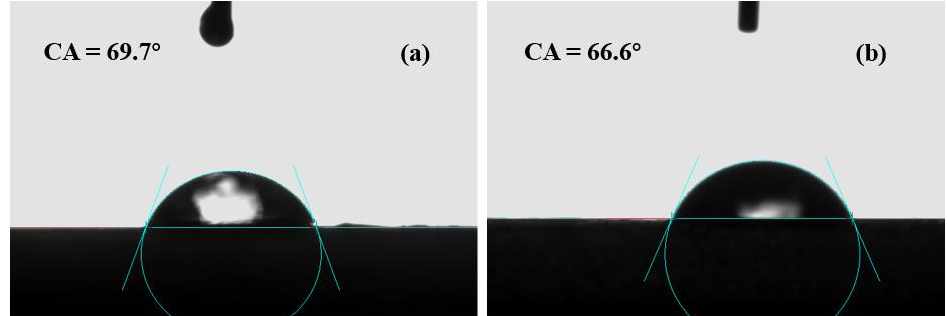
Figure 8. Contact angle of CA membrane ( a ) and CA/ZIF-8 membrane ( b ).